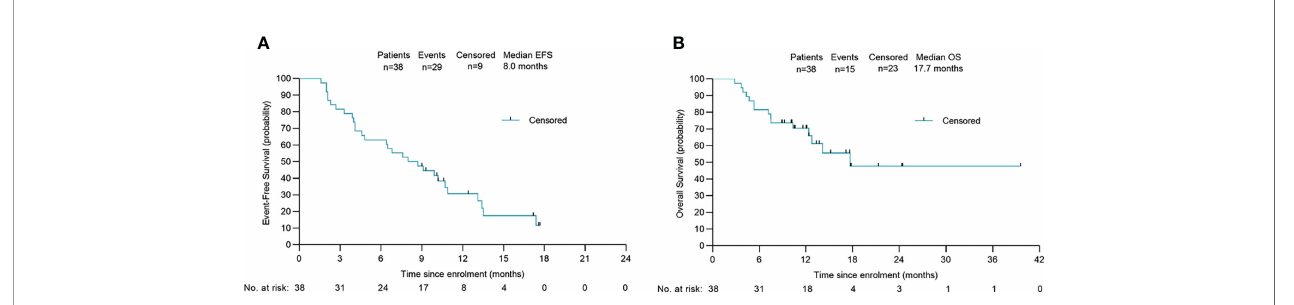
FIGURE 4 | Survival outcomes of 38 patients. Kaplan-Meier plots of overall event-free survival (A) and overall survival (B) . Probability of survival is shown at indicated time points. Numbers of patients at risk at indicated time points are shown below the x-axis. Censored patients are marked with a vertical line in the graph. EFS, event-free survival; OS, overall survival.